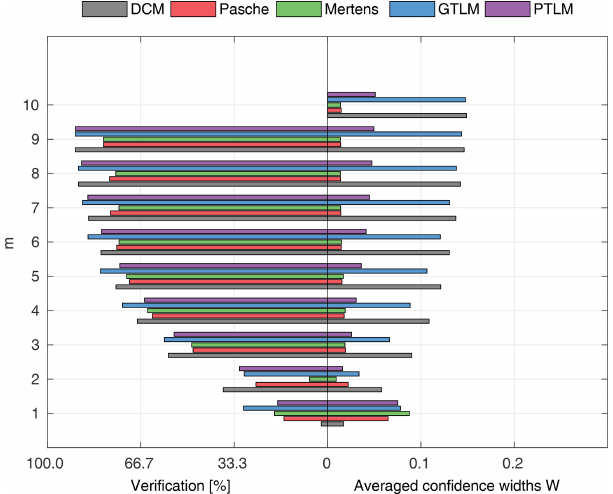
Figure 11. Percentage of the verification set ( M − m ) enclosed by confidence intervals and average width of confidence intervals for different numbers of data points for model identification ( m ); flume data set, case